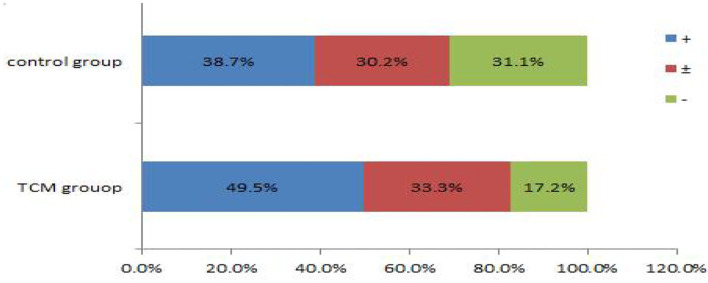
Comparison of endometrial blood flow velocities on the hCG triggering day.